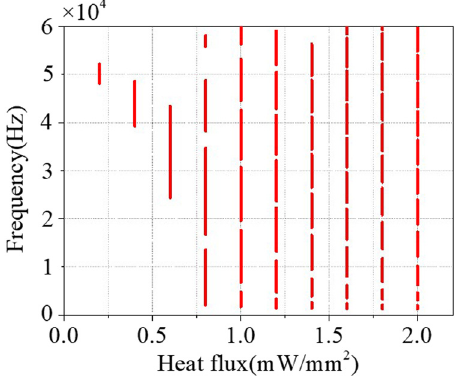
Figure 7: Bandwidths and locations of band gaps with di ff erent heat fl